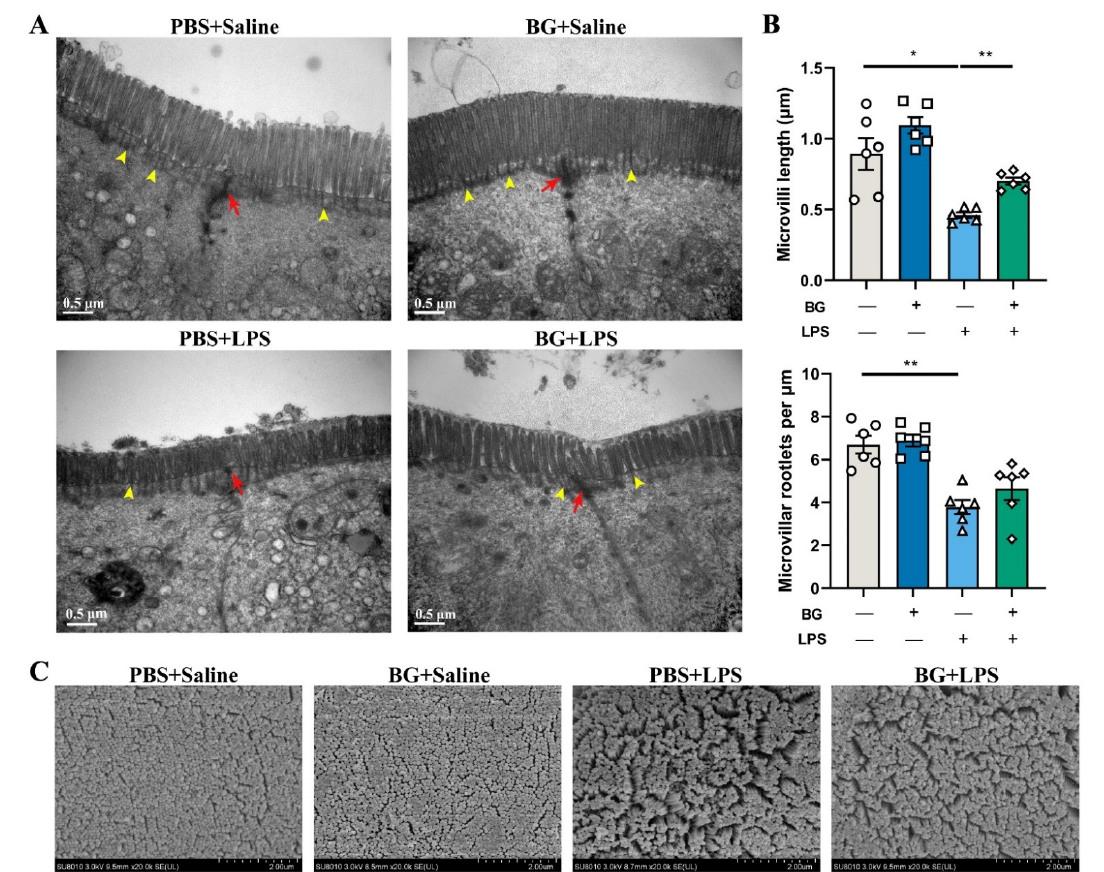
Figure 5. Attenuating effects of BG on ultrastructure of ileac epithelial cell in mice induced by LPS intraperitoneally injection. ( A ) transmission electron microscope images of ileum epithelial cells (scale bar = 0.5 µ m); ( B ) ileum epithelial cells microvilli length and average microvilli rootlet densities; “+” and “ − ” mean with and without corresponding treatments, respectively; ( C ) ileum epithelial cells scanning electron microscope images (20,000×). Yellow arrowheads designate rootlet ends, and red arrows designate tight junction structures. PBS+Saline, mice administration with PBS, and injection with saline; BG+Saline mice administration with 1.5 g/kg BW BG and injection with saline; PBS+LPS, mice administration with PBS and injection with LPS; BG+LPS, mice administered 1.5 g/kg BW BG and injection with LPS. Data are presented as mean ± SEM, n = 6. * and ** indicate significant difference ( p < 0.05 and p < 0.01, respectively). An unpaired t -test was used for statistical analysis between two groups.